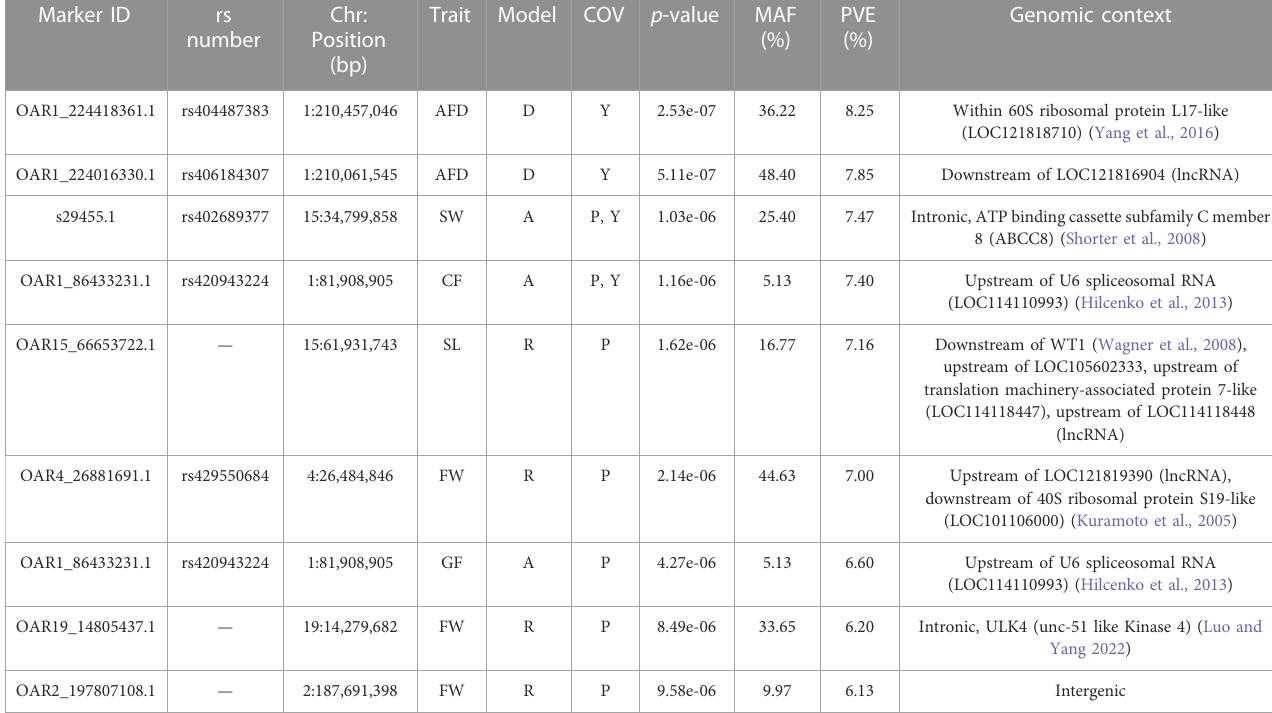
TABLE 4 Results of GWAS for wool quality characteristics. Each trait was tested individually in an EMMAX model and signi fi cant markers (genome-wide, p -values < 1.19e-06; chromosome-wide, p -values < 1.13e-05) are reported. Marker ID rs number